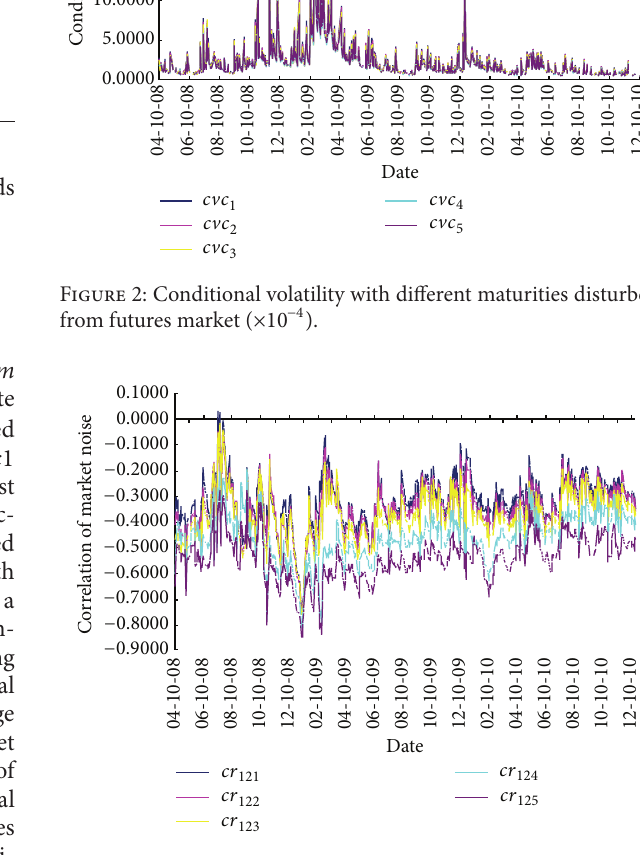
Figure 3: Conditional correlation of market noises between spot and futures. Table 2: Statistical description of conditional correlation of market noises between spot and futures